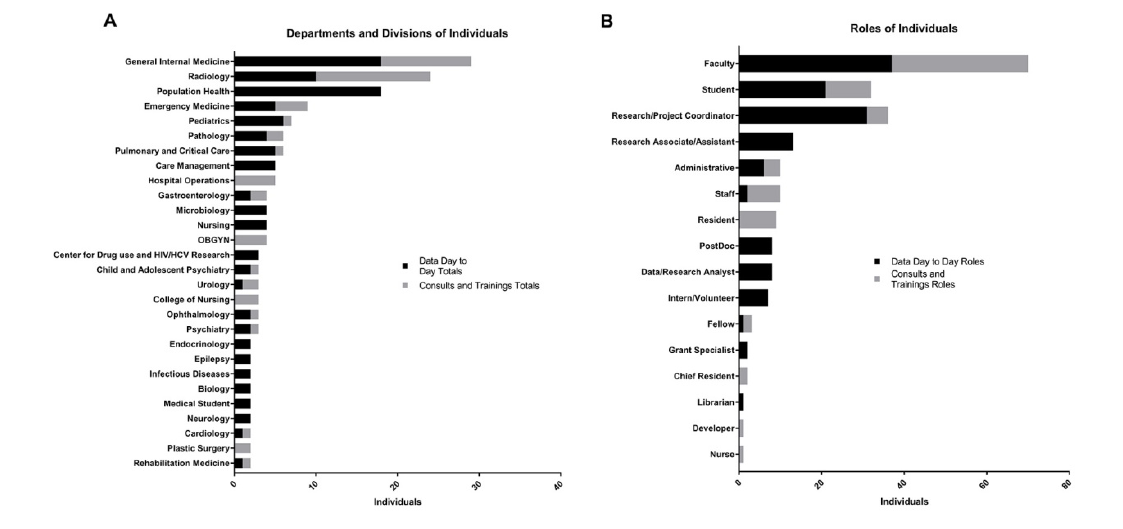
Figure 1 Individual REDCap interactions by department or division and by